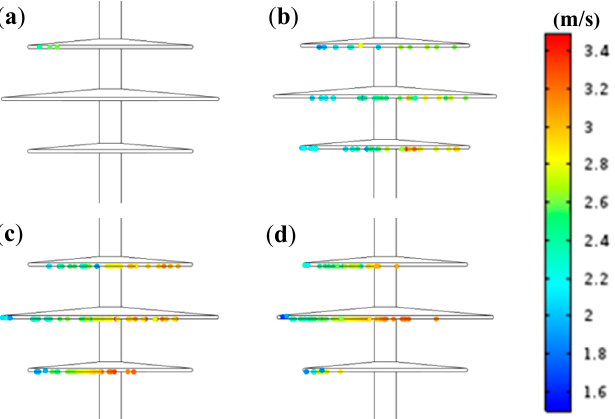
Figure 5. The distribution map of contamination particles frozen on insulator surface, when ( a ) Q = 1 p.u.; ( b ) Q = 10 p.u.; ( c ) Q = 30 p.u.; and ( d ) Q = 50 p.u.